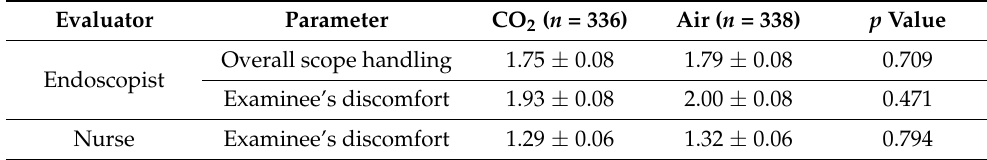
Table 3. Results of endoscopist and nurse